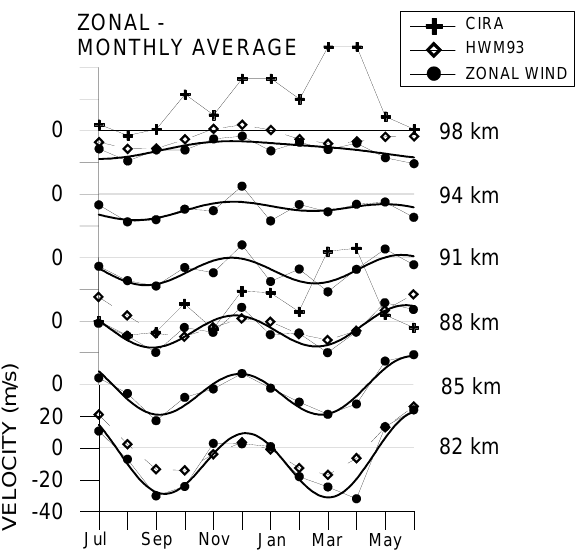
Fig. 1 - Mean (monthly average) Zonal wind at heights from 82 to 98 km between July 2004 Fig. 1. Mean (monthly average) zonal wind at heights from 82 to 98km between July 2004 and June 2005 observed at Cariri (solid and June 2005 observed at Cariri (solid circles). Thin lines represent the fitting of circles). Thin lines represent the fitting of annual and semiannual annual and semiannual oscillations. Open diamonds are the winds provided by oscillations. Open diamonds are the winds provided by HWM93 for Cariri at 82, 88 and 98km. Solid crosses represent the winds HWM93 for Cariri at 82, 88 and 98 km. Solid crosses represent the winds given by given by CIRA model at 87.5 and CIRA model at 87.5 and 98 km.